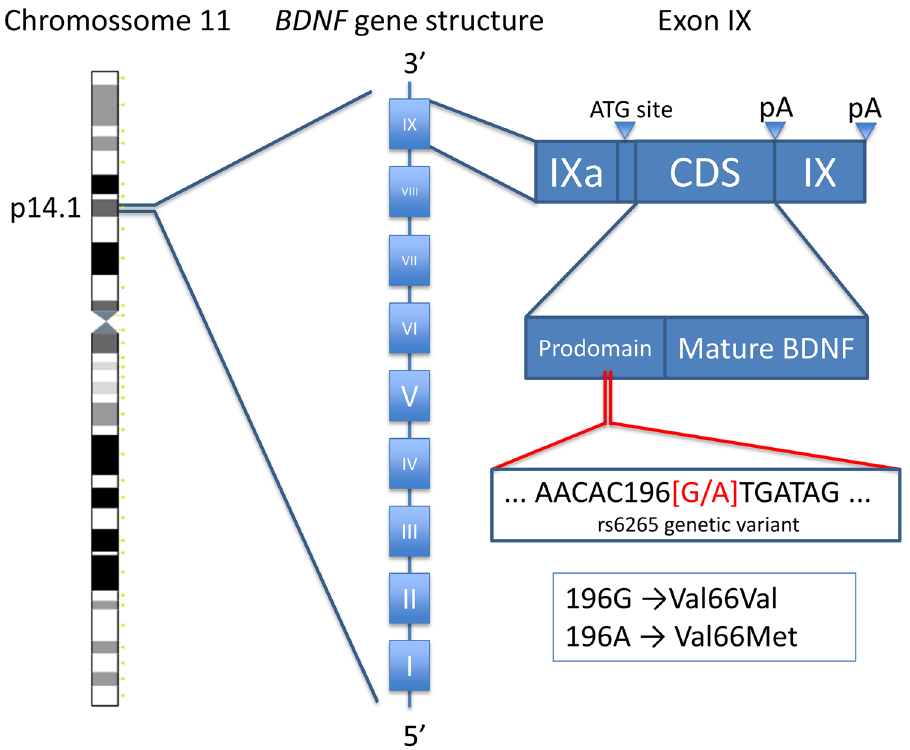
Figure 3. Representation of the BNDF location and structure. The Val66Met (rs6265) polymorphism of the BDNF gene consists of a substitution of valine for methionine in the BDNF prodomain. BDNF exons are represented by boxes noted with roman algorisms, while lines represent introns. The SNP locus is in the prodomain region of the IX exon. CDS coding DNA sequence. pA polyadenylation sites. ATG site initiation codon. BDNF brain-derived neurotrophic factor; Val/Val Val66Val homozygous. Val/Met Val66Met